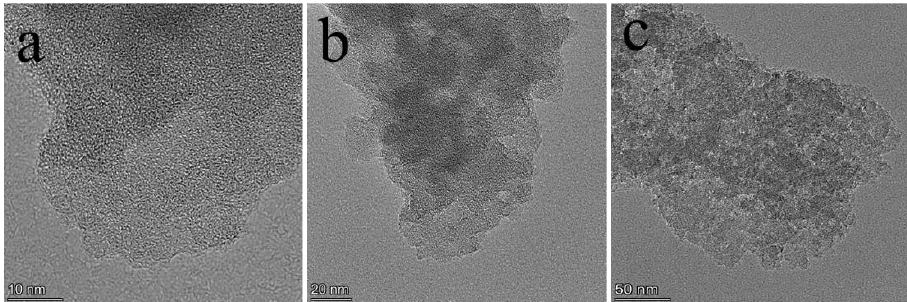
Figure 5. TEM images of [HCP-CH 2 -Im][Cl]-1 ( a ) 10 nm; ( b ) 20 nm; ( c ) 50 nm).